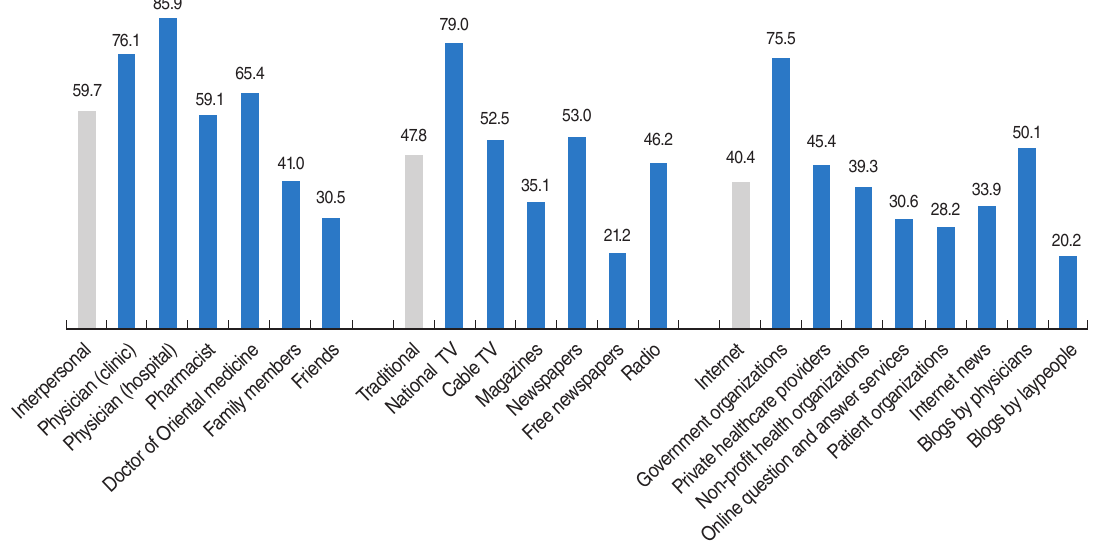
Figure 1. Comparison of levels of trust in interpersonal channels, traditional media, and online sources of health information. Table 2. Factors associated with trust in various online sources of health information